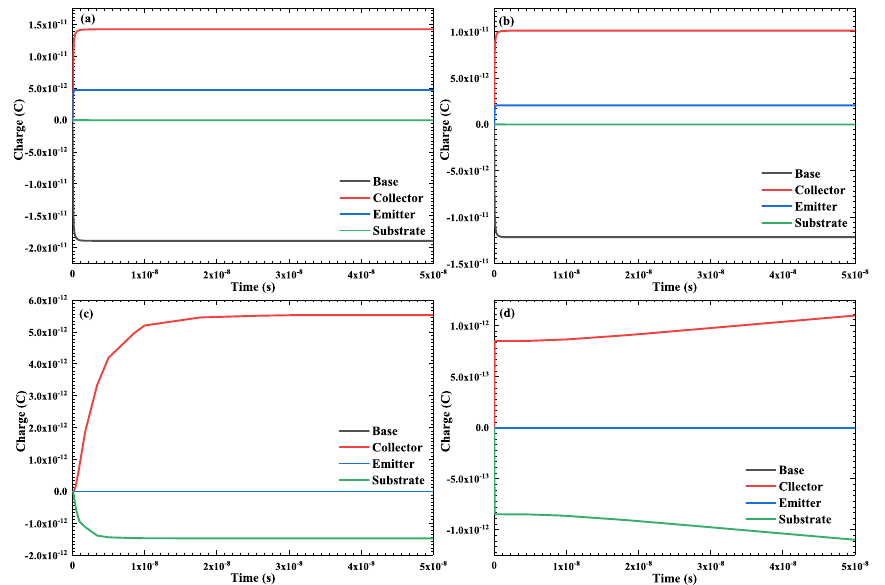
Figure 5. The collected charge change in each terminal with time as heavy ions irradiates the center of emitter ( a ), base ( b ), collector ( c ) and substrate ( d ) of the SiGe HBT.